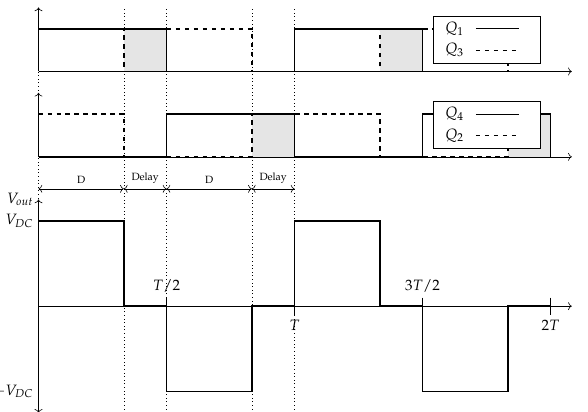
Figure 7. Output voltage in a full-bridge inverter with an square-wave activation and phase- shifting. Figure 7. The output voltage in a full-bridge inverter with an square-wave activation and